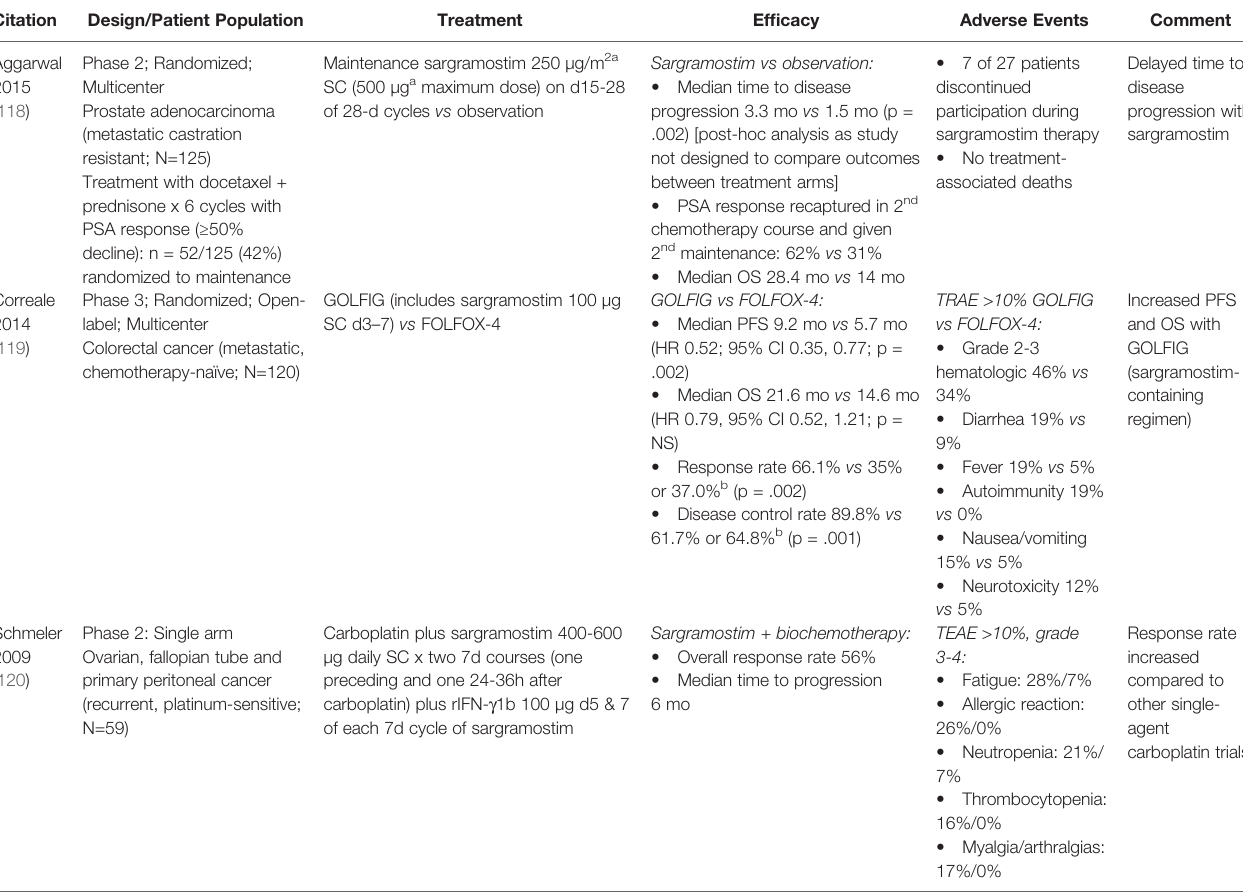
Reductions in infections and fatal infection are reported (100, 101, 103, 104). Decreases in other adverse events included less grade 3-5 AEs, grade 3-5 gastrointestinal (GI) and pulmonary AEs and mucositis (98, 103).